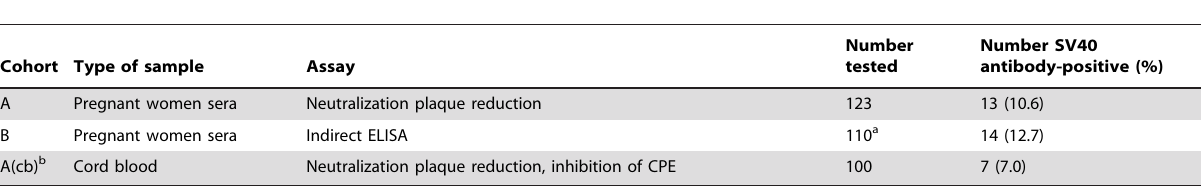
Table 2. Detection of SV40 antibodies in sera from pregnant women and in cord blood.